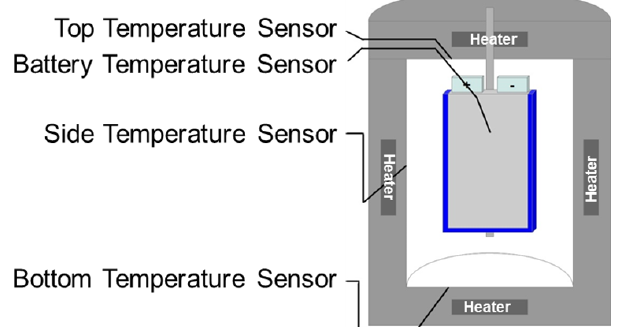
Figure 4. Schematic drawing of an accelerating rate calorimeter with a pouch cell in the cylindrical chamber.